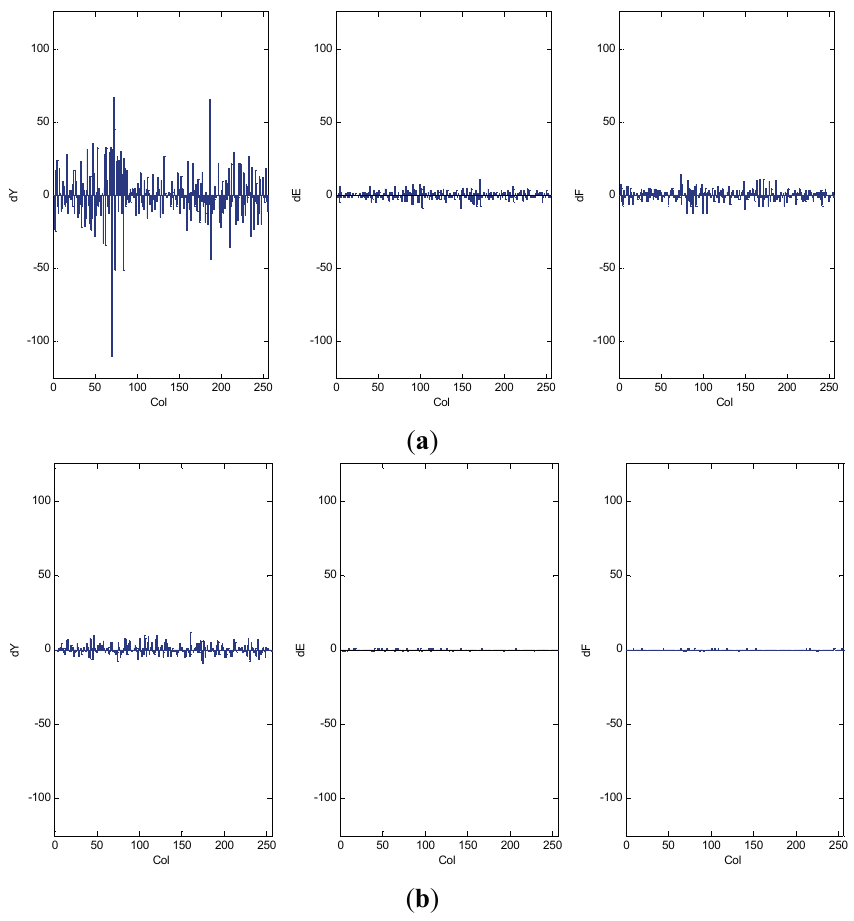
Figure 6. Change in consecutive pixel value at row 128 of ( a ) standard 256 × 256 “mandrill” image; ( b ) 256 × 256 WLI endoscopy image.